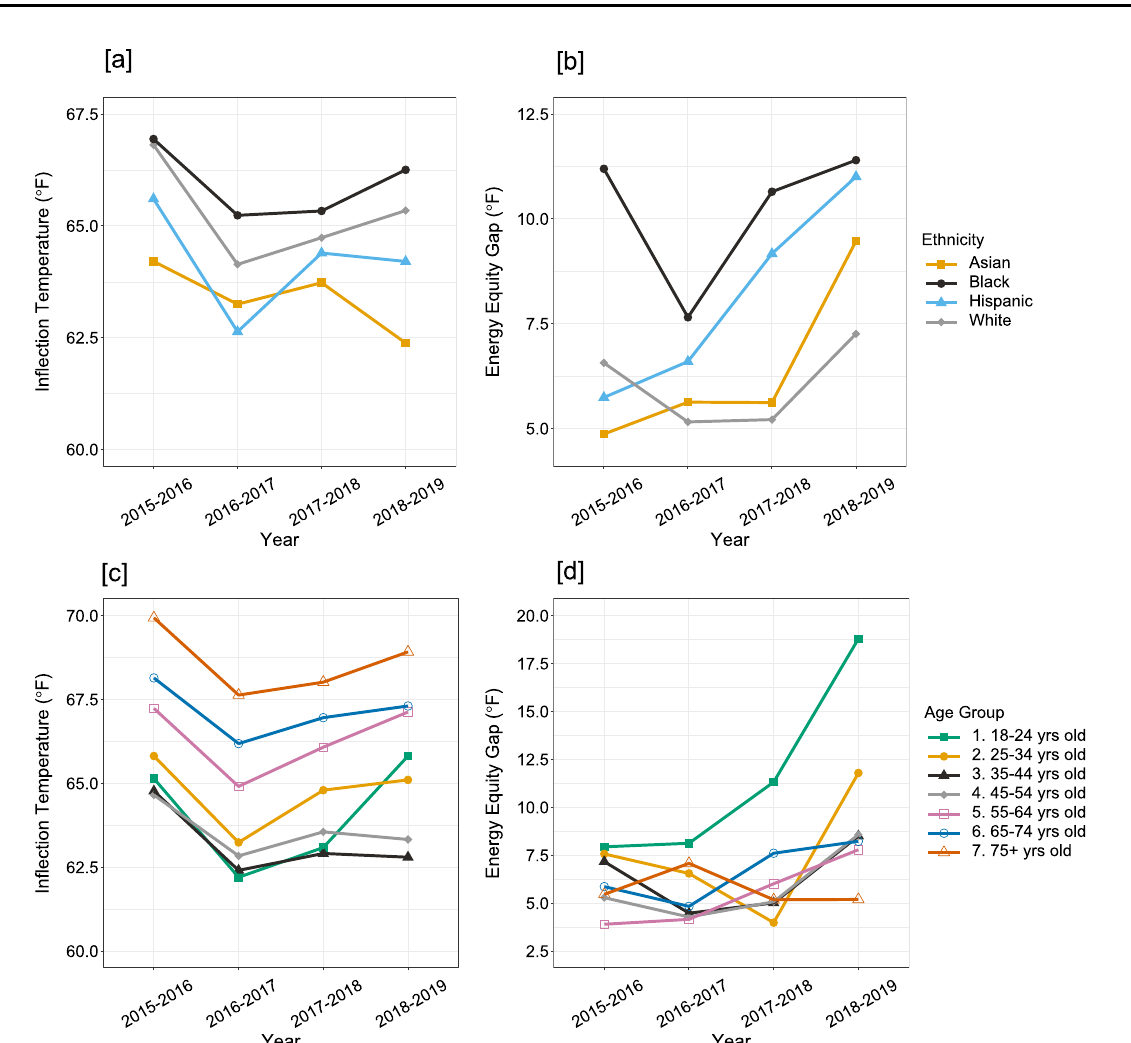
Fig. 5 Inter- and intra-group comparison of the in fl ection temperature and energy equity gap for ethnicity and age groups. Median in fl ection temperatures by ( a ) ethnicity and ( c ) age group show disparities across demographics. The energy equity gap highlights energy consumption behavior differences between high and low-income populations within their respective ( b ) ethnicity and ( d ) age groups. See Supplementary Information Notes 3 and 4 for more